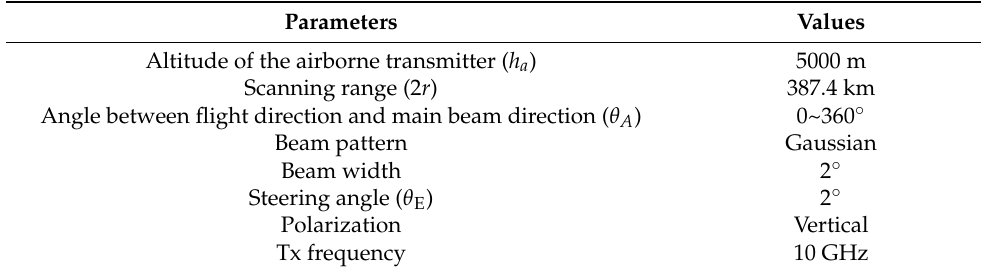
Figure 5. Air-to-ground scenario in the synthetic aperture radar (SAR) application across Pohang (S 4 ) and Heuksando ( S 6 ) in Korea. Table 3. Two-dimensional path loss simulation setup.